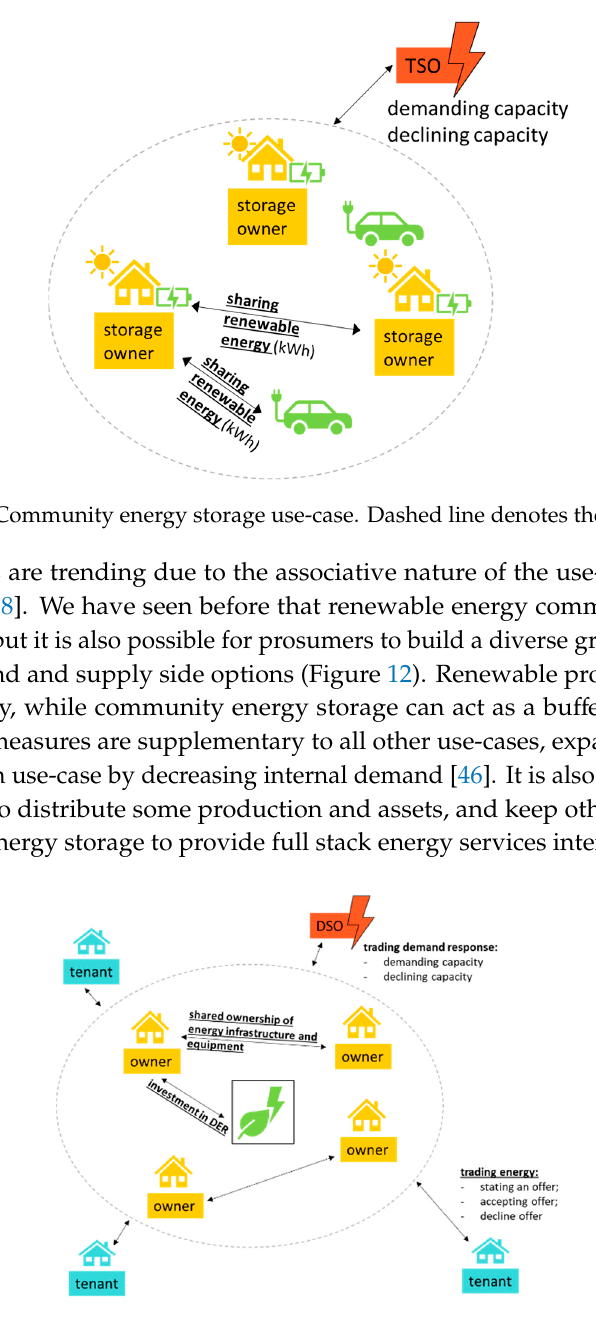
Figure 12. Hybrid renewable-demand response community use-case. Dashed line denotes the community.